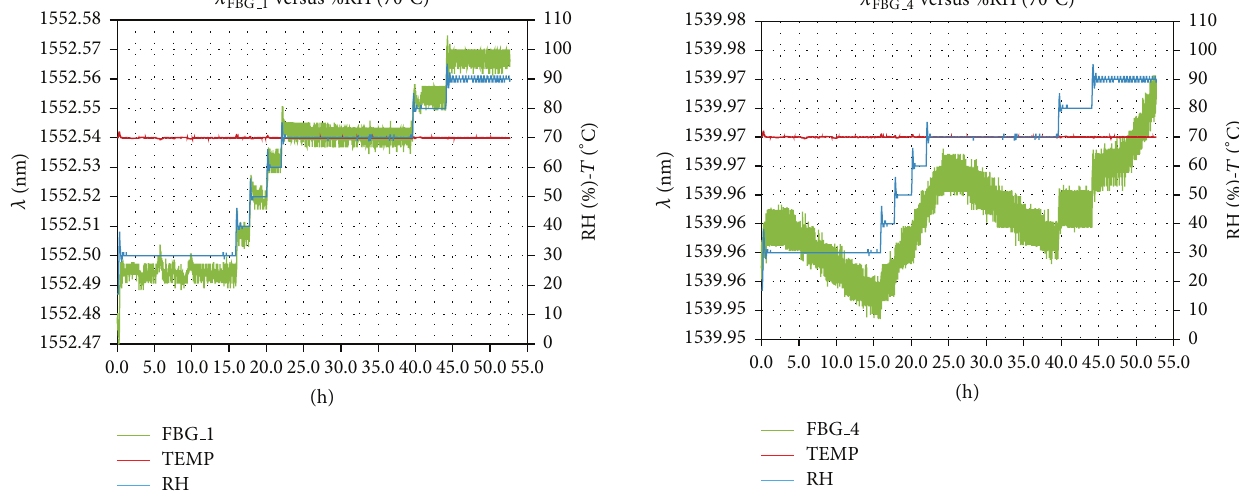
Figure 4: Bragg wavelength shift of FBG 1 (green, left axis) as a function of the %RH (blue, right axis) at a temperature of 70 ∘ C (red, right axis).